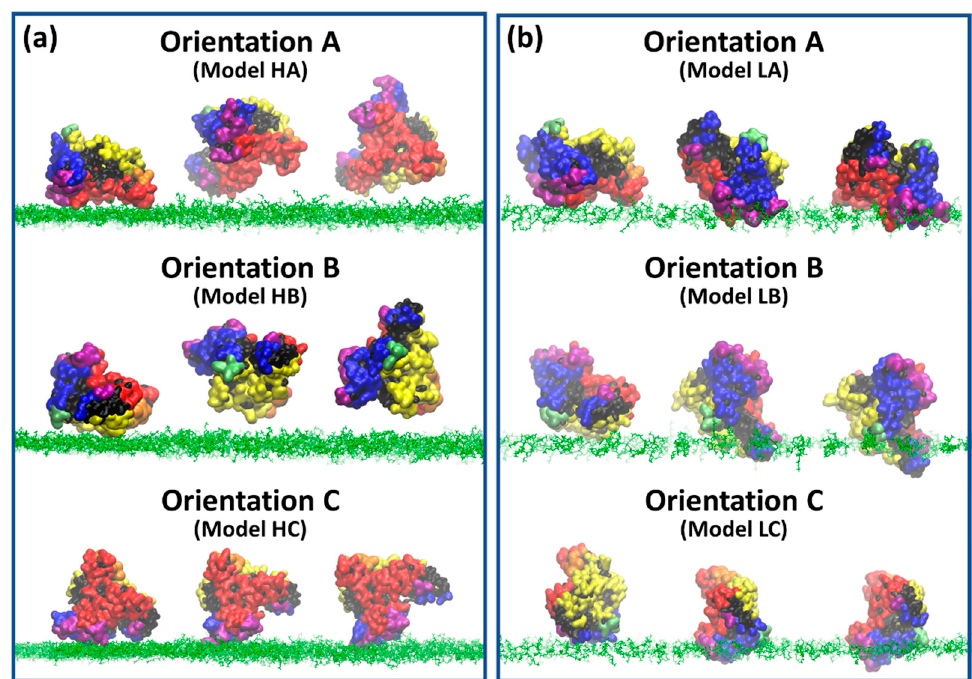
Figure 3. Snapshots from the MD simulations for BSA-polymer chain surfaces at 0 ns (left), 60 ns (middle), and 120 ns (right) at high-density surface ( a ) and at low-density surface ( b ) in three initial orientations designated A, B and C. Models at high-density surface are named HA, HB, and HC. Models at low-density surface are named LA, LB, and LC.